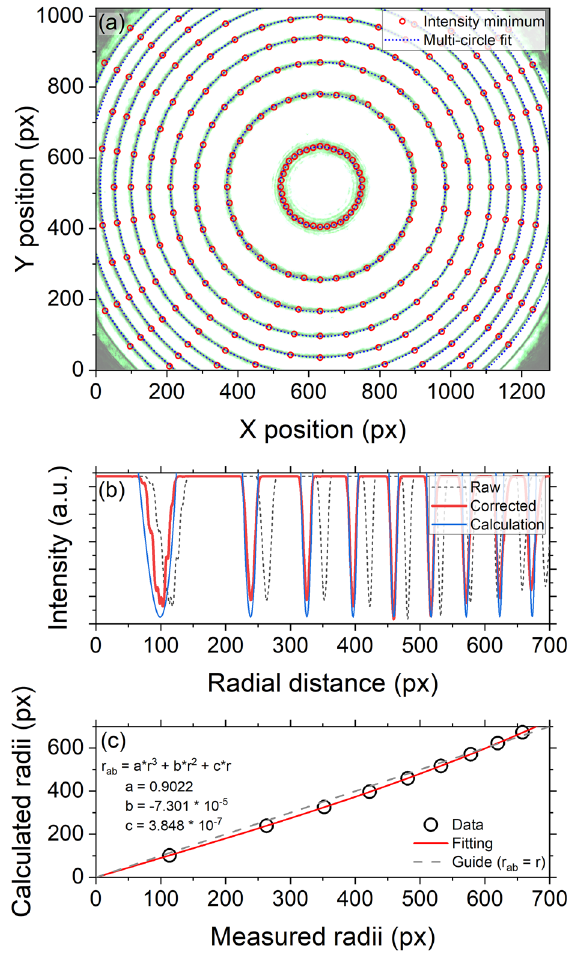
Figure 4. Analysis of the interference ring pattern obtained from the empty DAC ( t s = 18.41 µm and k L = 69.23) with a 532 nm laser. ( a ) The intensity minima (red circle) are determined with a local Gaussian fitting of radial intensity profiles and fitted with a multiple-circle fitting method (blue dotted line) to determine the center and the radii of each ring. ( b ) The experimental (black dotted) and corrected (red) radial intensity profiles are compared with a calculated one (blue). Note that we overexpose the pattern in order to accentuate the locations of the minima and the amplitude of the calculated profile is properly adjusted to improve the visual comparison with the experimental profile. ( c ) Third-order polynomial fitting (red) between the experimental and calculated ring radii (black circle) with an identity line (gray